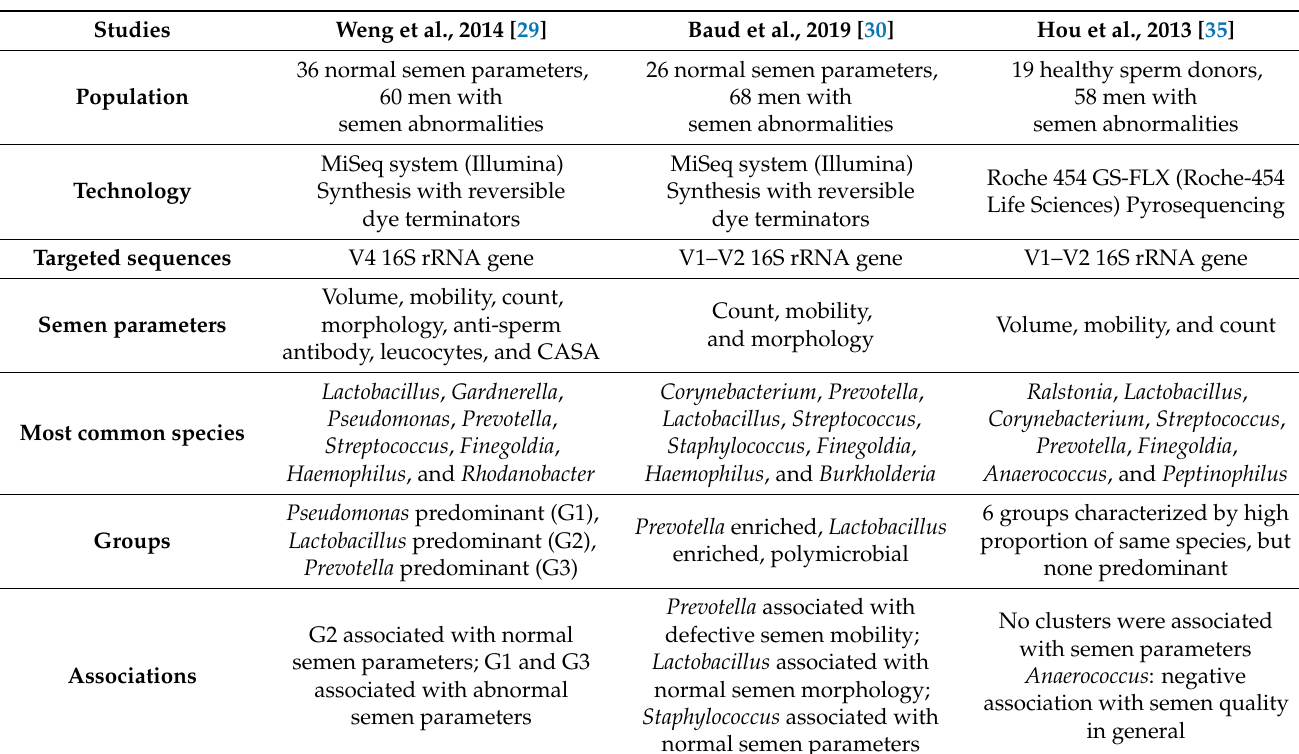
Table 3. Main results of previous studies describing semen microbiota depending on semen biological parameters. CASA = computer-assisted semen